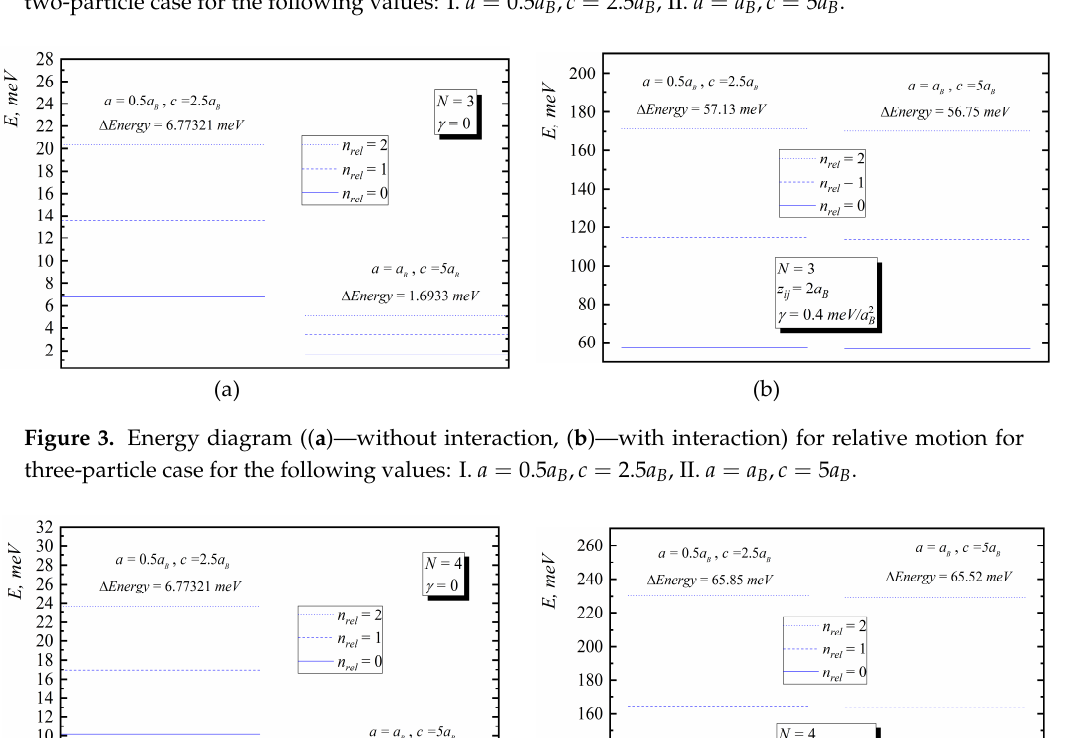
Figure 2. Energy diagram (( a )—without interaction, ( b )—with interaction) for relative motion for a two-particle case for the following values: I. a = 0.5 a B , c = 2.5 a B , II. a = a B , c = 5 a B .